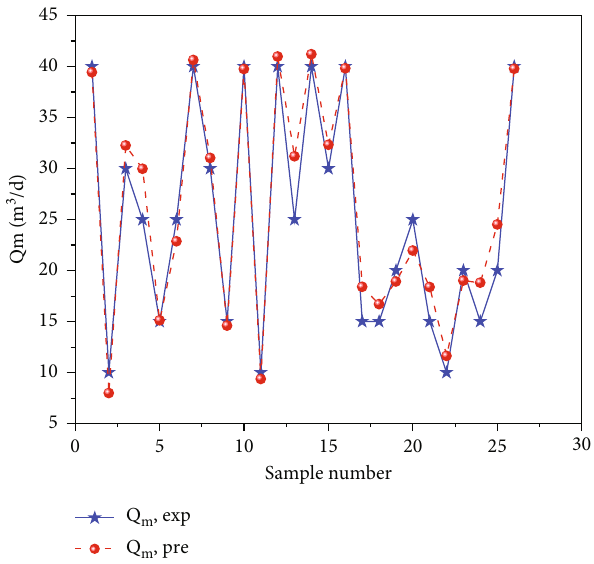
Figure 10: Comparison chart of predicted fl ow and real fl ow.